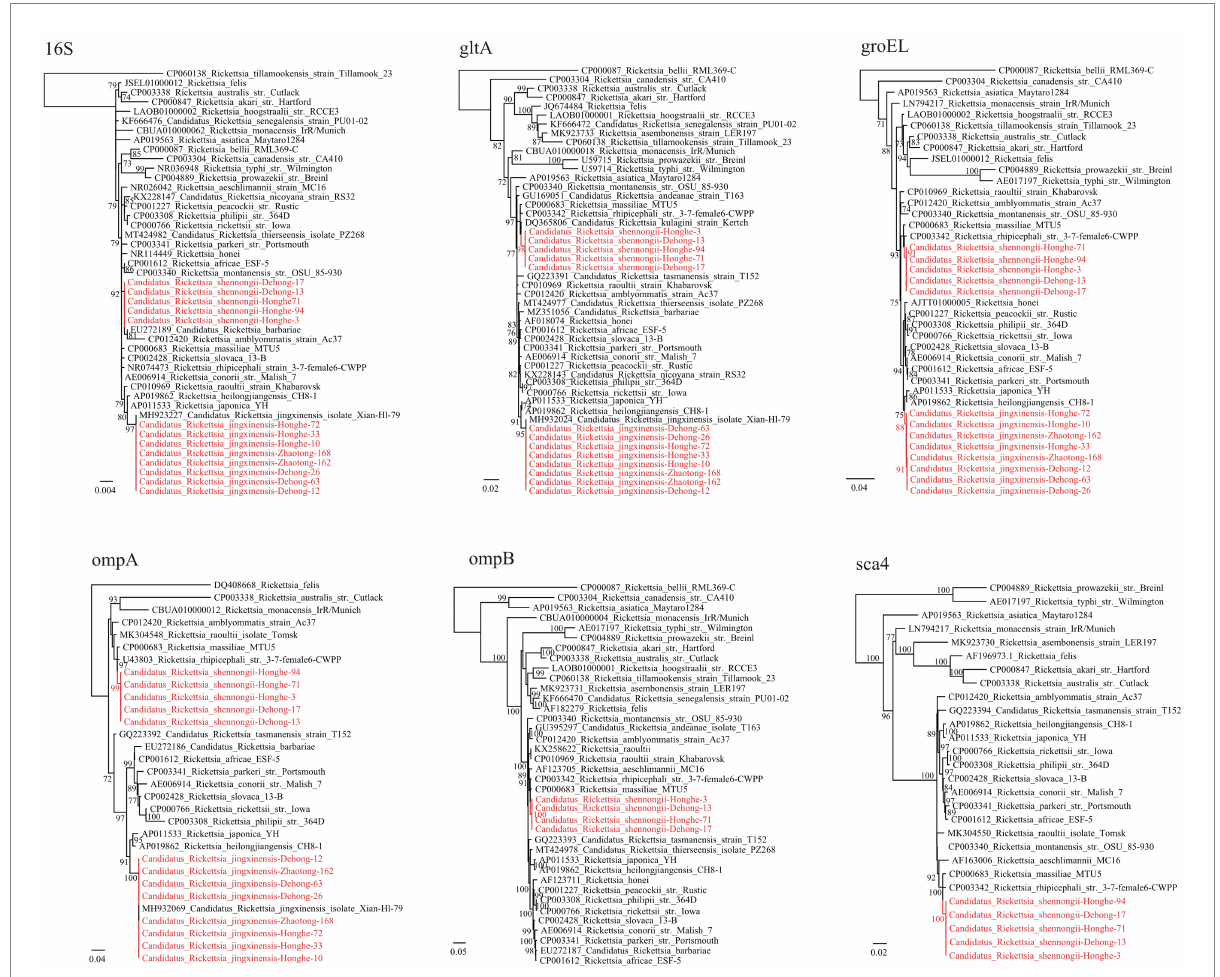
FIGURE 2 Phylogenetic trees constructed by the PhyML 3.0 software based on the nucleotide sequences of 16S rRNA (1,172 bp), groEL (1,038–1,042 bp), gltA (1,004 bp), ompA (664–712 bp), ompB (4,704–4,707 bp) and sca4 (2,560–2,566 bp) genes of Rickettsia strains. The bootstrap values were shown on the nodes. Red: the strains identified in this